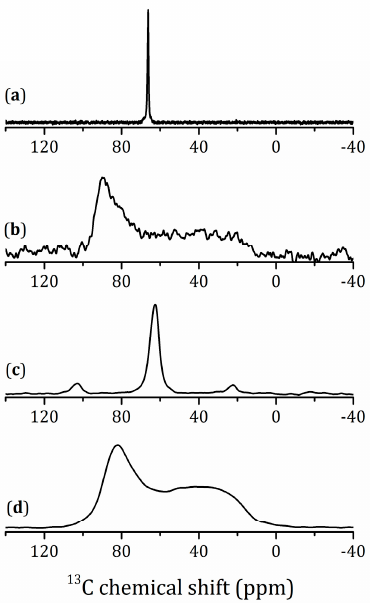
Figure 5. 13 C{ 1 H} cross-polarization (CP) NMR spectra of HTL 3 × MeOH under magic angle spinning (MAS) at ν rot = 14 kHz ( a ) and static ( b ) conditions in magnetic field 9.4 T and 13 C-NMR spectra of Ti(CH 3 O) 4 under MAS at ν rot = 5 kHz ( c ) and static ( d ) conditions in magnetic field 7 T.